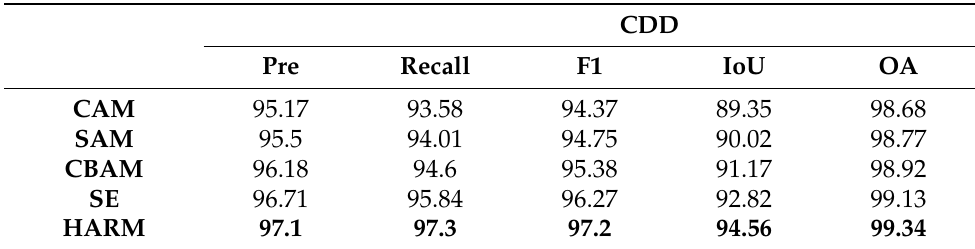
Table 6. Ablation experiments performed on the CDD dataset applying different attention modules to our model. The highest score is marked in bold. All scores are expressed as a percentage